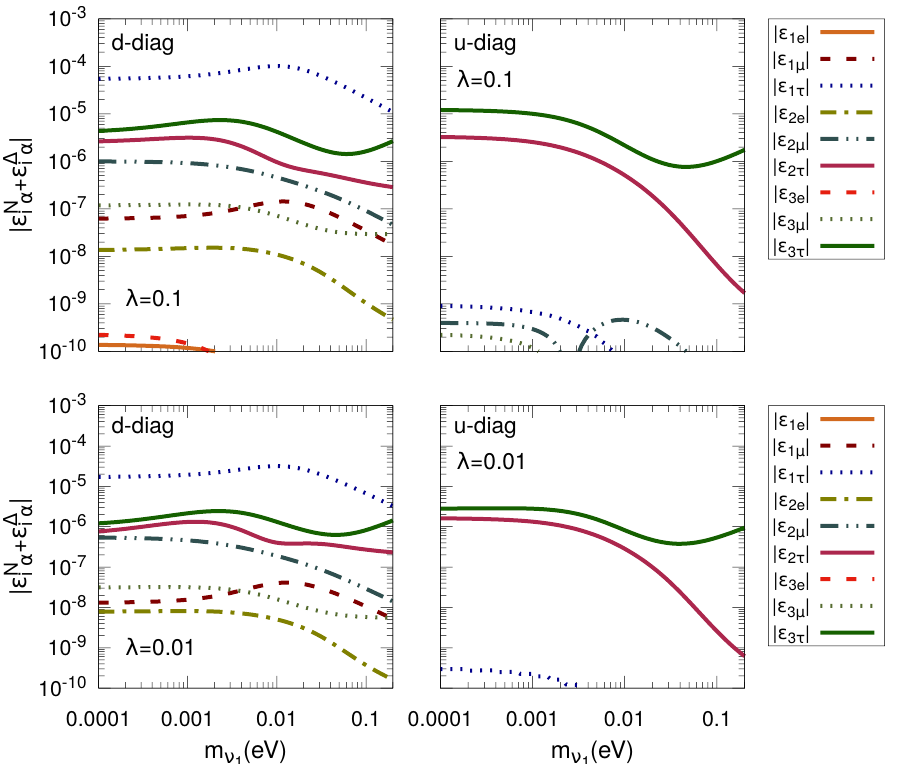
Figure 4 . The CP-asymmetry vs. the lightest neutrino mass for hierarchical spectrum scenario of RH (cid:23) masses. The top left (right)-panel correspond to d(u)-quark diagonal basis for (cid:21) = 0 : 1. The bottom left(right) panel correspond to d(u)-quark diagonal basis but for (cid:21) = 0 :